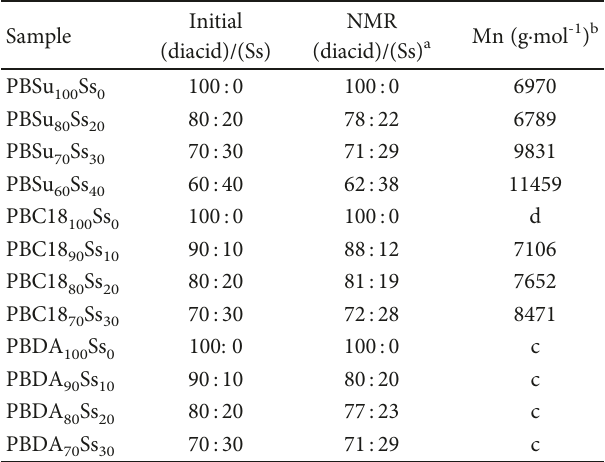
a Diacid unit/sulfosuccinate unit molar ratio in oligoesters determined by 1 H NMR. b Molecular weight (Mn) determined by 1 H NMR. c End groups not detected by 1 H